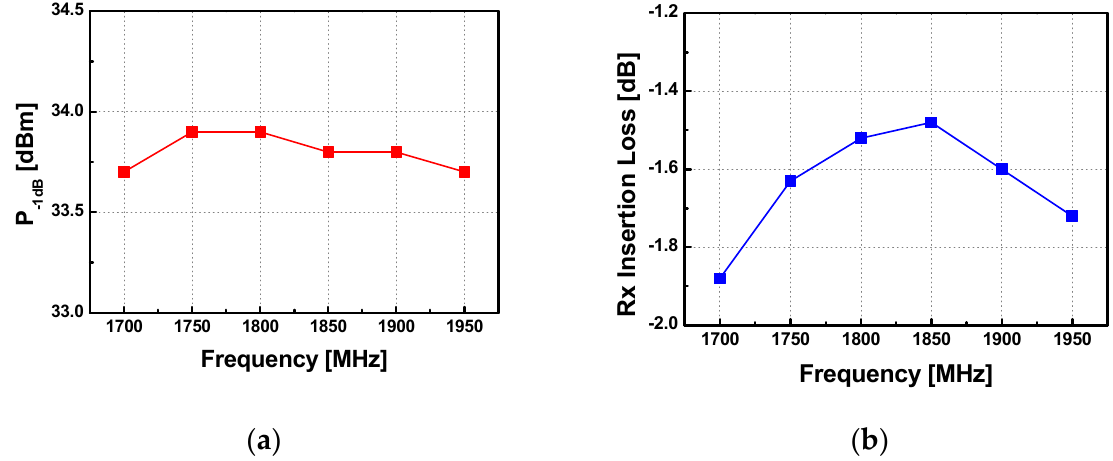
Figure 22. Measurement results of ( a ) P 1dB of the differential switch and ( b ) Rx insertion loss of the switch.